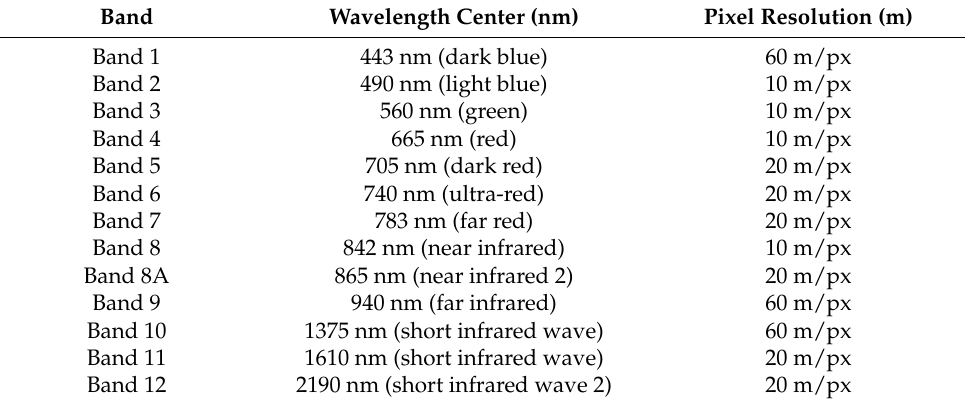
Table 1. Sentinel-2 satellite bands of the European Copernicus program, operated by the European Space Agency (ESA), indicating the electromagnetic wavelength of the center point of each band and its pixel resolution in meters. Band Wavelength Center (nm) Pixel Resolution